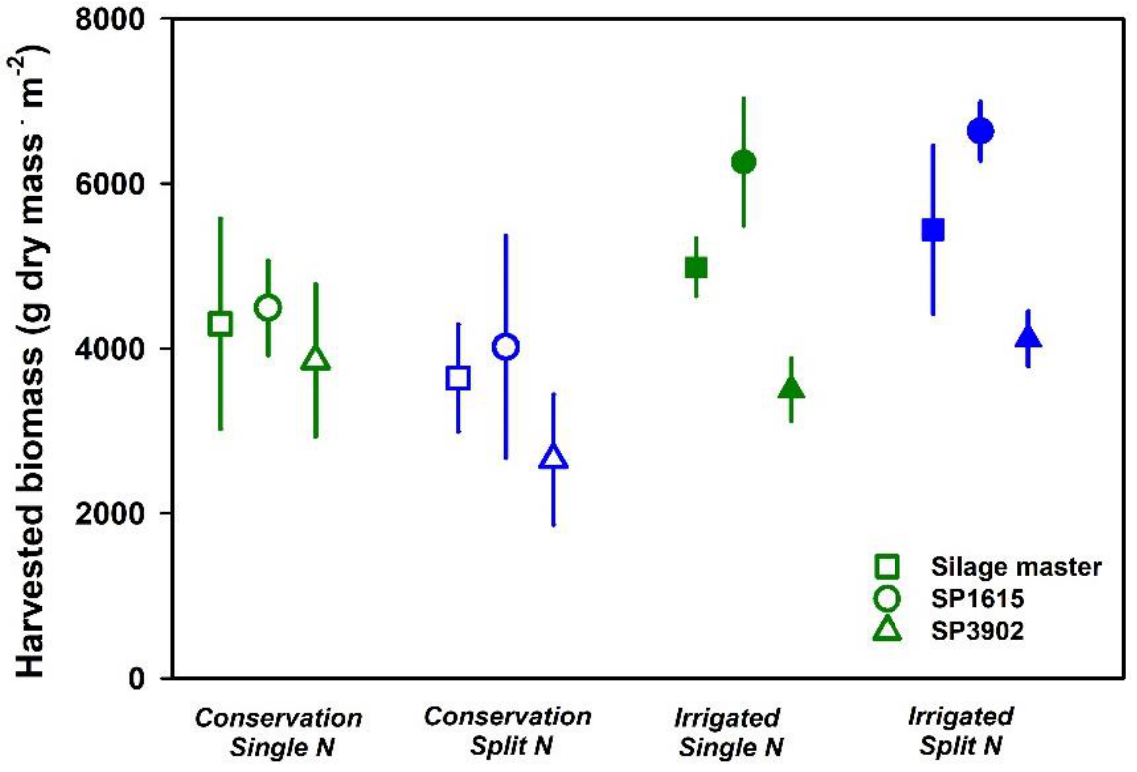
Figure 7. Harvested sorghum biomass from fields under 30% less irrigation and full irrigation, and with N fertilizer applied once at the start of the growing season or spilt into two applications. Symbols designate sorghum genotypes planted. Values are mean dry mass per irrigation/fertilizer/genotype group, error bars are ± 1 SD.